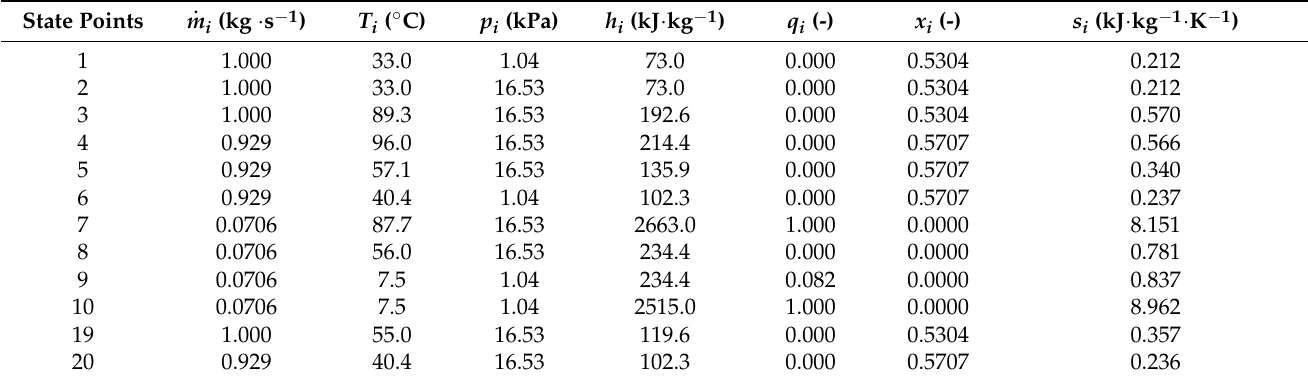
Table 1 contains the AHP operating conditions referring to Figure 2, for the streams 1 to 10 and 19 to 20. Table 1. AHP operating conditions referring to Figure